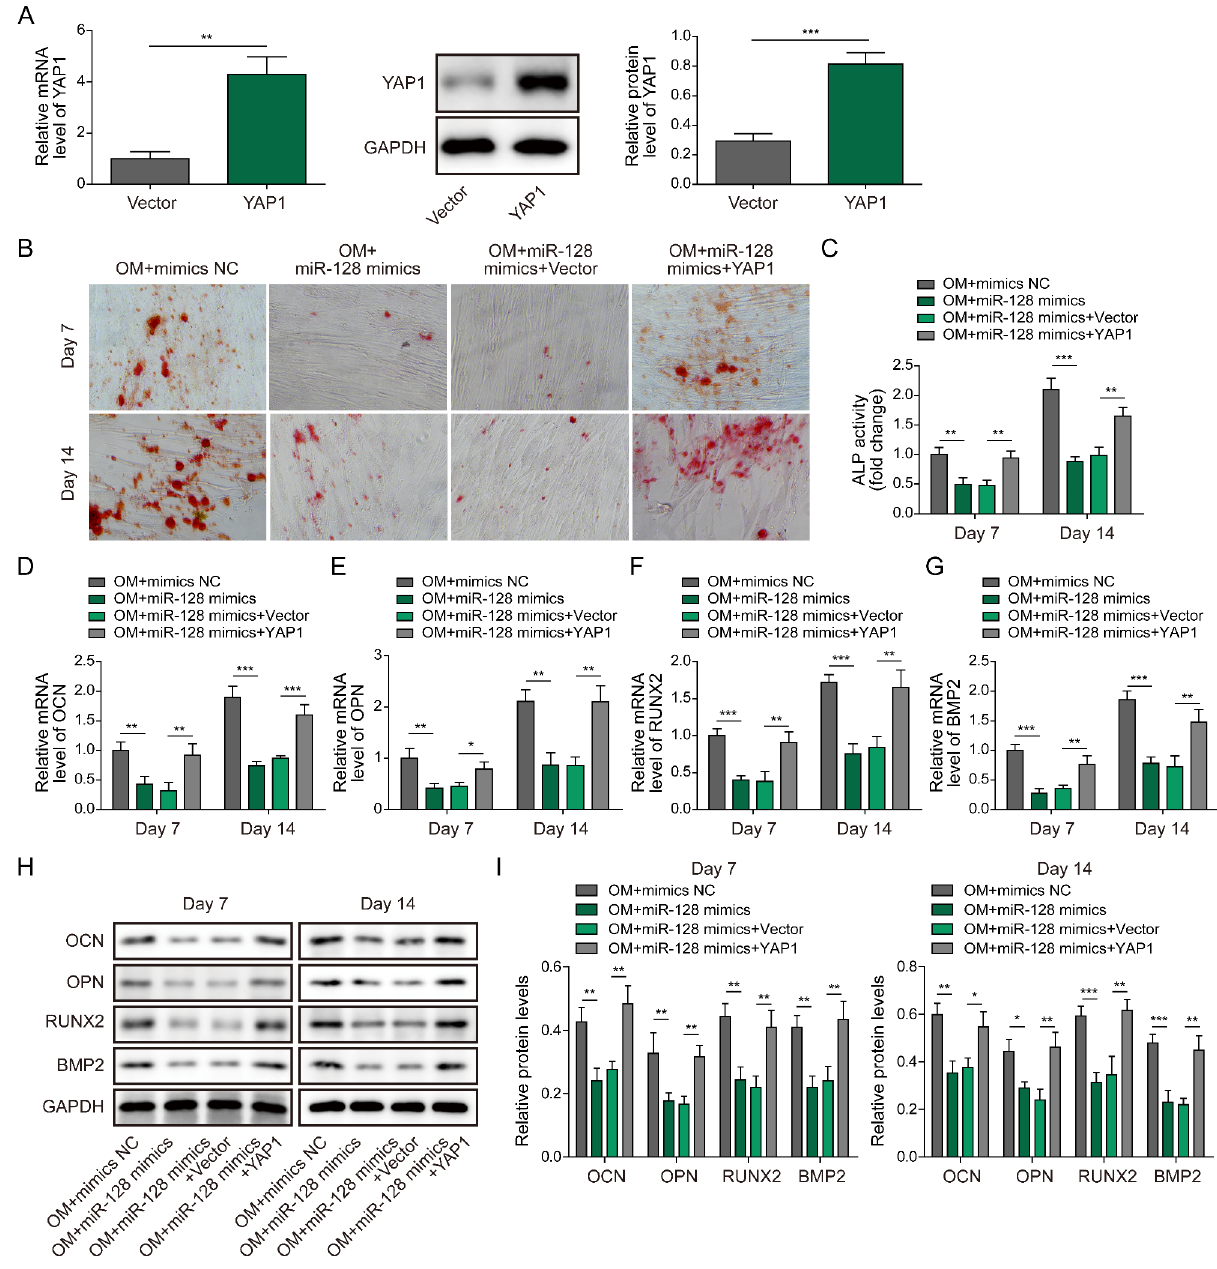
Fig. 8 MiR-128 restrains BMSC osteogenic differentiation via targeting YAP1. (A) The overexpression efficiency of YAP1 in BMSCs was validated by qRT-PCR and Western blotting. (B) Alizarin Red staining was performed to detect the matrix mineralization of BMSCs from OM + mimics NC, OM + miR-128 mimics, OM + miR-128 mimics + vector, OM + miR-128 mimics + YAP1 groups. (C) ALP activity of BMSCs from multiple groups. (D-H) The mRNA and protein levels of OCN, BMP2, OPN, and RUNX2 in BMSCs were assessed by qRT-PCR and Western blotting. * P < 0.05, ** P < 0.01 and *** P <